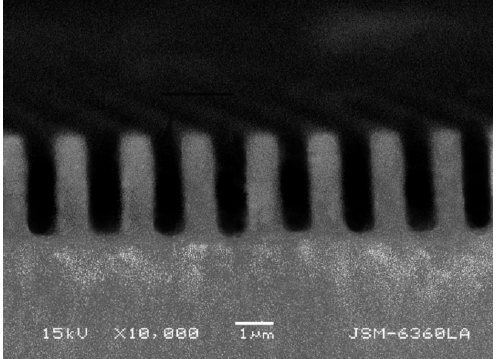
Figure 23. Theoretical efficiency of a fused ‐ silica grating with λ = 1550 nm, m = − 1 order, and TE polarization as a function of groove depth and line density for a rectangular profile with a duty cycle of 0.5.